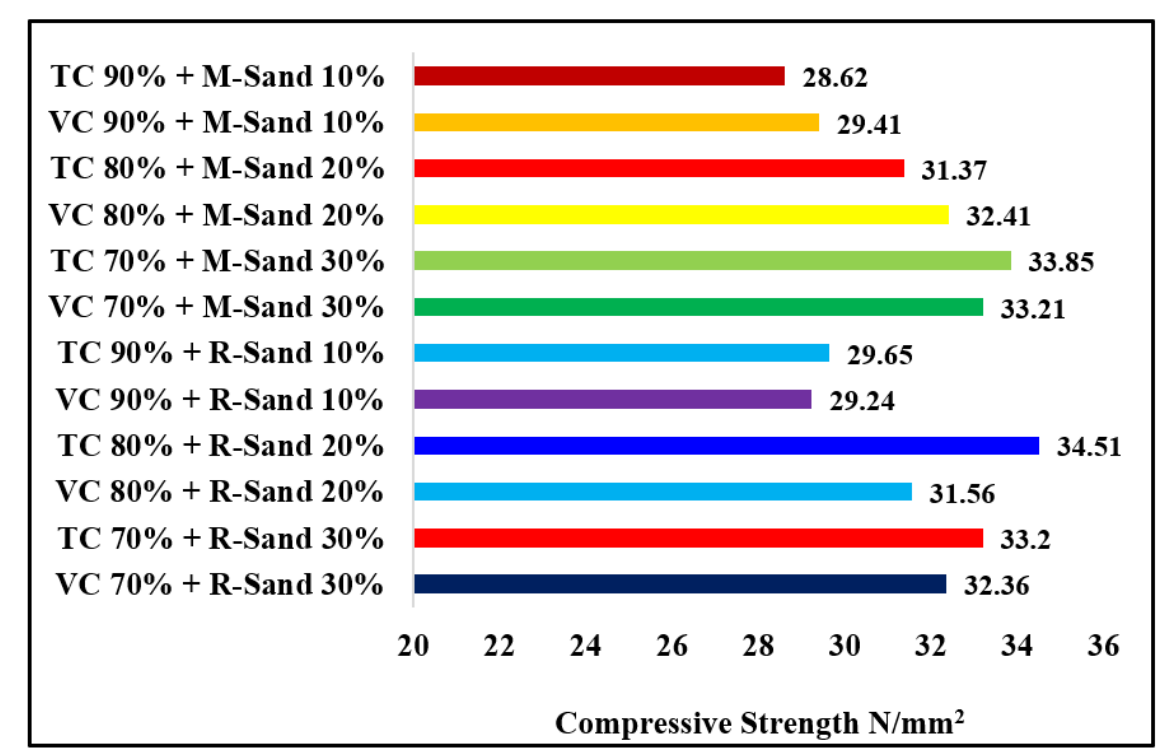
Figure 14. Compressive strength of modified concrete with partial replacement of silica sand.